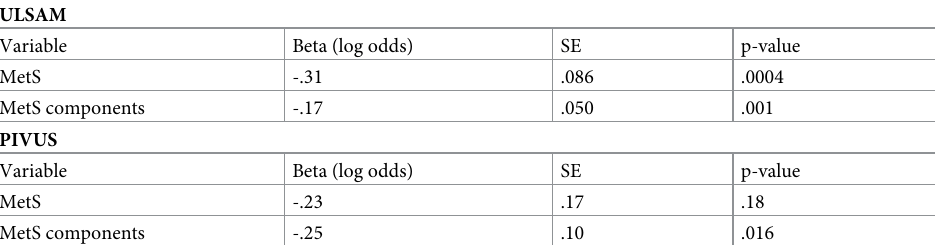
Table 3. Relationships between change in presence of the Metabolic syndrome (MetS) or change in number of MetS components and change in physical activity from age 50 to age 82 in ULSAM, and between age 70 and 80 in